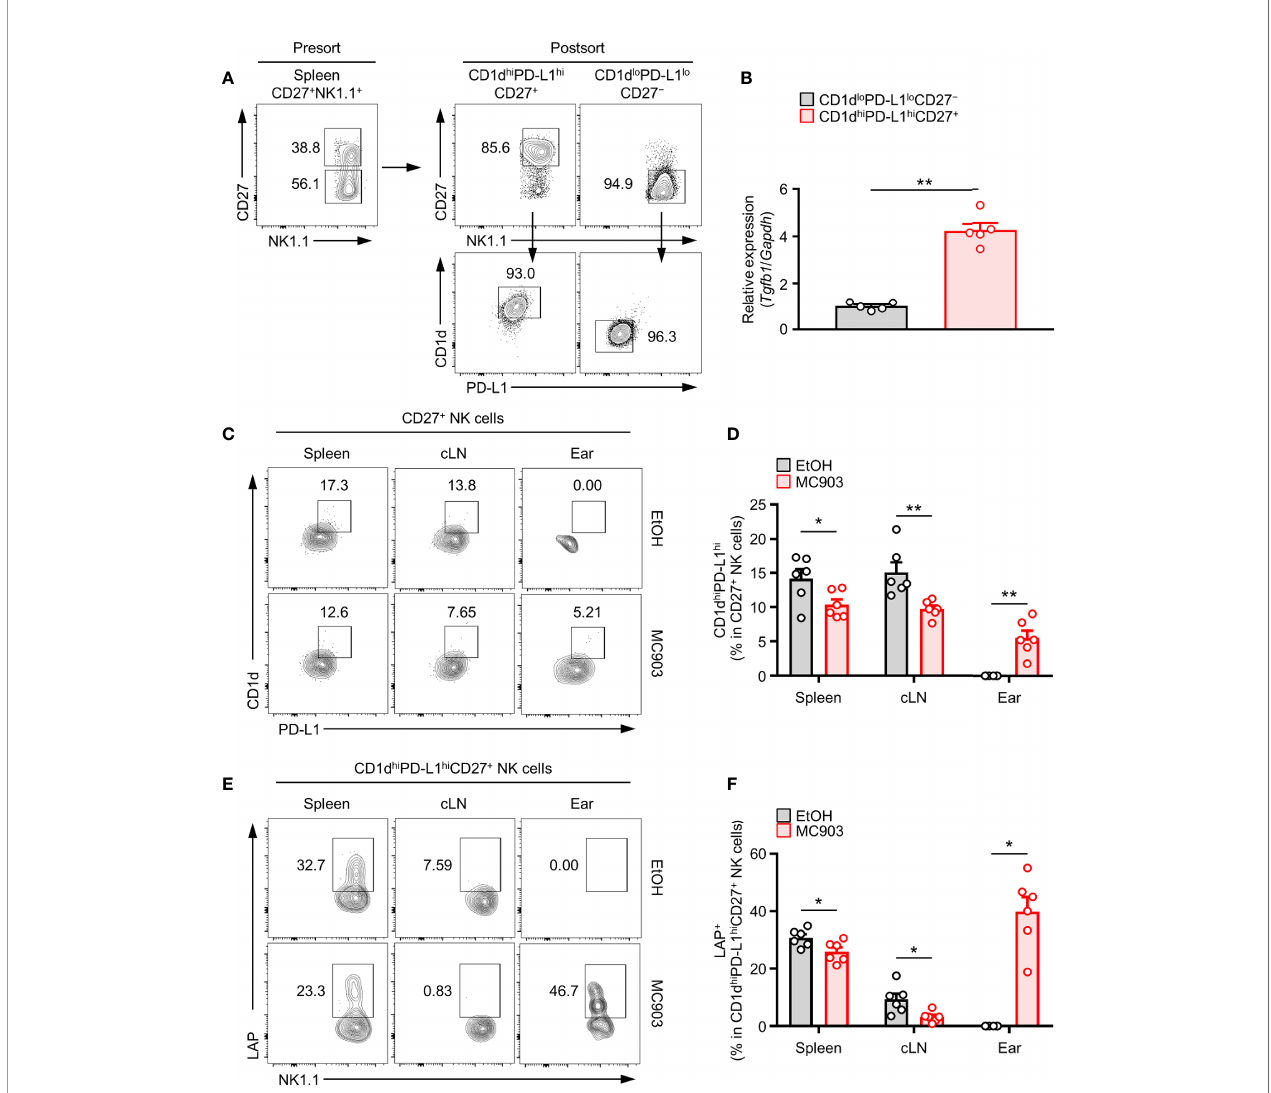
FIGURE 4 | Correlation between TGF- b -Producing NK cells and CD1d hi PD-L1 hi CD27 + NKreg subsets in an AD mouse model. (A) Splenic CD1d hi PD-L1 hi CD27 + or CD1d lo PD-L1 lo CD27 – NK subsets were isolated from mice by sorting with a FACSAria fl ow cytometer. Representative fl ow cytometry images and purities of sorted cells. (B) Histograms showing gene expression of TGF- b from the splenic CD1d hi PD-L1 hi CD27 + or CD1d lo PD-L1 lo CD27 – NK subsets (n = 5). (C) Representative fl ow cytometry images and (D) histograms for the frequency of CD1d hi PD-L1 hi subsets in LAP + CD27 + NK cells in spleen, cLN, and ear from AD mouse (n ≥ 6 per each group). (E) Representative fl ow cytometry images and (F) histograms for the frequency of LAP+ in CD1d hi PD-L1 hi CD27 + NK cells in spleen, cLN, and ear from AD mouse (n ≥ 6 per each group). All values represent the mean ± SEM. * p < 0.05; ** p <